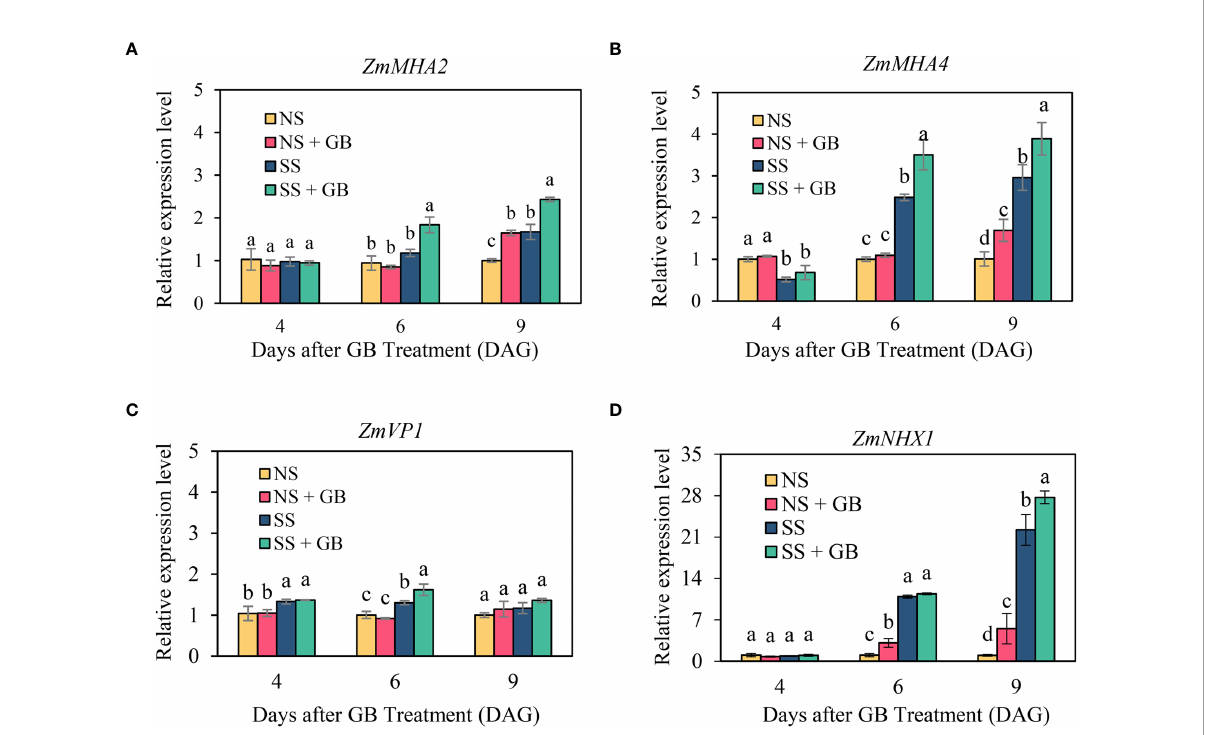
FIGURE 6 Effects of GB on the expression of (A) ZmMHA2, (B) ZmMHA4, (C) ZmVP1, and (D) ZmNHX1 in the leaves of maize plants under non-stressed (NS) and salinity-stressed (SS) conditions. The values indicate the mean, while the vertical error bars indicate the standard deviation (n = 3). The different letters in each panel represent signi fi cant differences determined with Fisher ’ s protected LSD test at P <